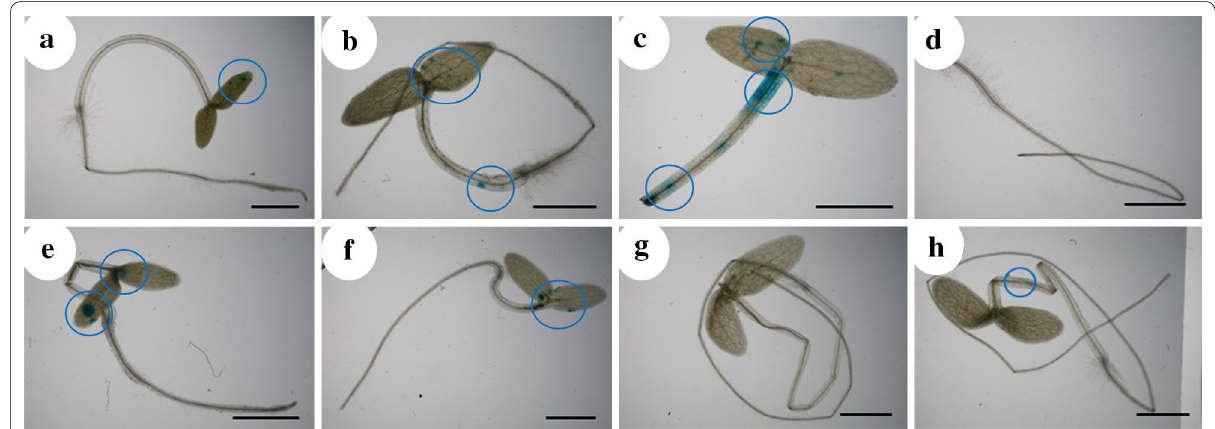
Fig. 2 GUS staining results of ice plant seedlings infected with the A. tumefaciens EHA105 strain harboring the pBISN1 binary vector. Representative GUS staining results of 5‑ ( a – d ), 3‑ ( e , f ), and 7‑day‑old ( g , h ) seedlings. Blue circles indicate blue spots in intact seedlings ( a , e , g ); seedlings with root‑tip‑removed ( b , f , h ); shoot ( c ) and root ( d ). Tissues showing blue spots indicate successful transformation. Bar